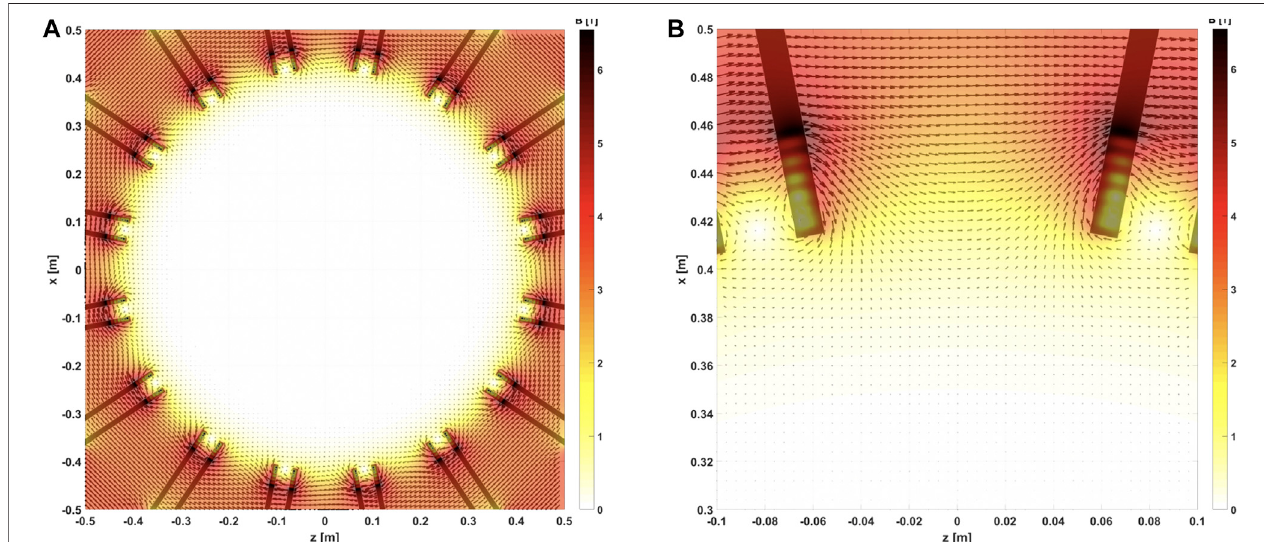
FIGURE3|(A) Map ofthemagnetic fi eldinside thebore (80 cm diameter) volume. The fi eld value, when exiting thecoils, dropsquicklytovaluesin theorder of μ T. (B) Zoomonthetransitionvolumebetweenthecoilsandthebore.Themagnetic fi eldinthebeamandrangemonitorvolumes,at40 cmradius,isabout0.7 T,anddrops to 10 mT at about 30 cm.